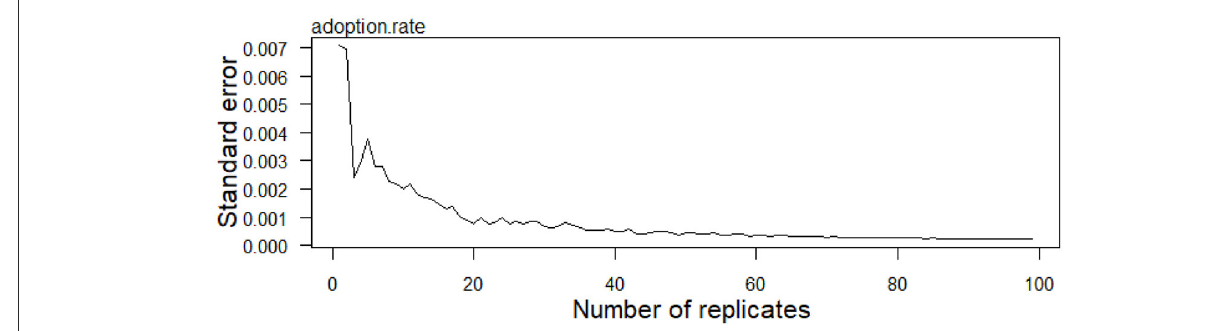
FIGURE4 Comparison of the standard errors of the adoption rate for the different numbers of replicates.